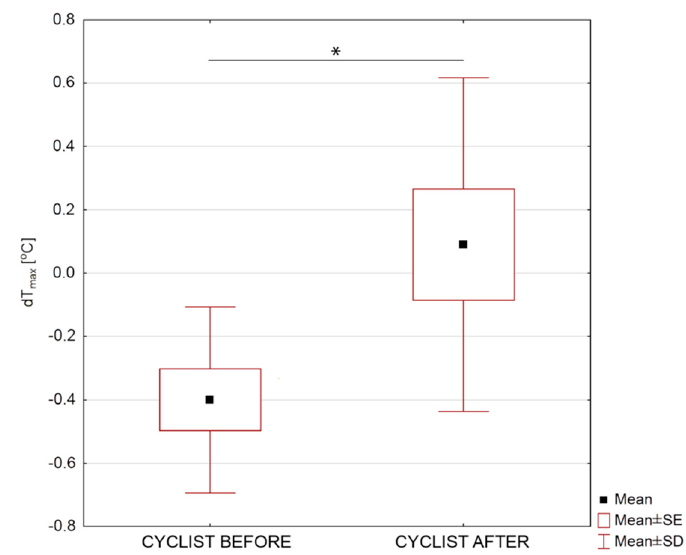
Figure 6. Maximum body surface temperature difference for studied group of cycling sportspersons before and after one training year. Statistically significant changes were marked as * on the graph with p < 0.05.